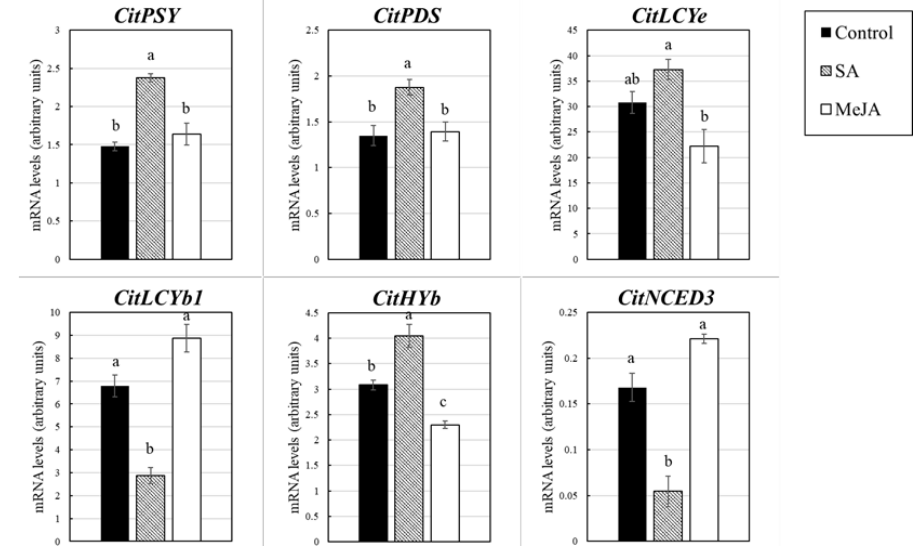
Figure 4. E ff ect of salicylic acid (SA) and methyl jasmonate (MeJA) treatments on the expression of carotenoid metabolism related genes in the juice sacs of Satsuma mandarin in vitro. The mRNA levels were analyzed by TaqMan real-time RT-PCR, and the expression of 18S ribosomal RNA (rRNA) was used as a control to normalize the raw data. Columns and bars represent the means and SE ( n = 3), respectively. Different letters indicate significant differences at the 5% level by Tukey’s HSD test. PSY, phytoene synthase; PDS, 15- cis -phytoene desaturase; LCYe, lycopene epsilon-cyclase; LCYb1, lycopene beta-cyclase1; HYb, beta-carotene 3-hydroxylase; NCED3, 9- cis -epoxycarotenoid